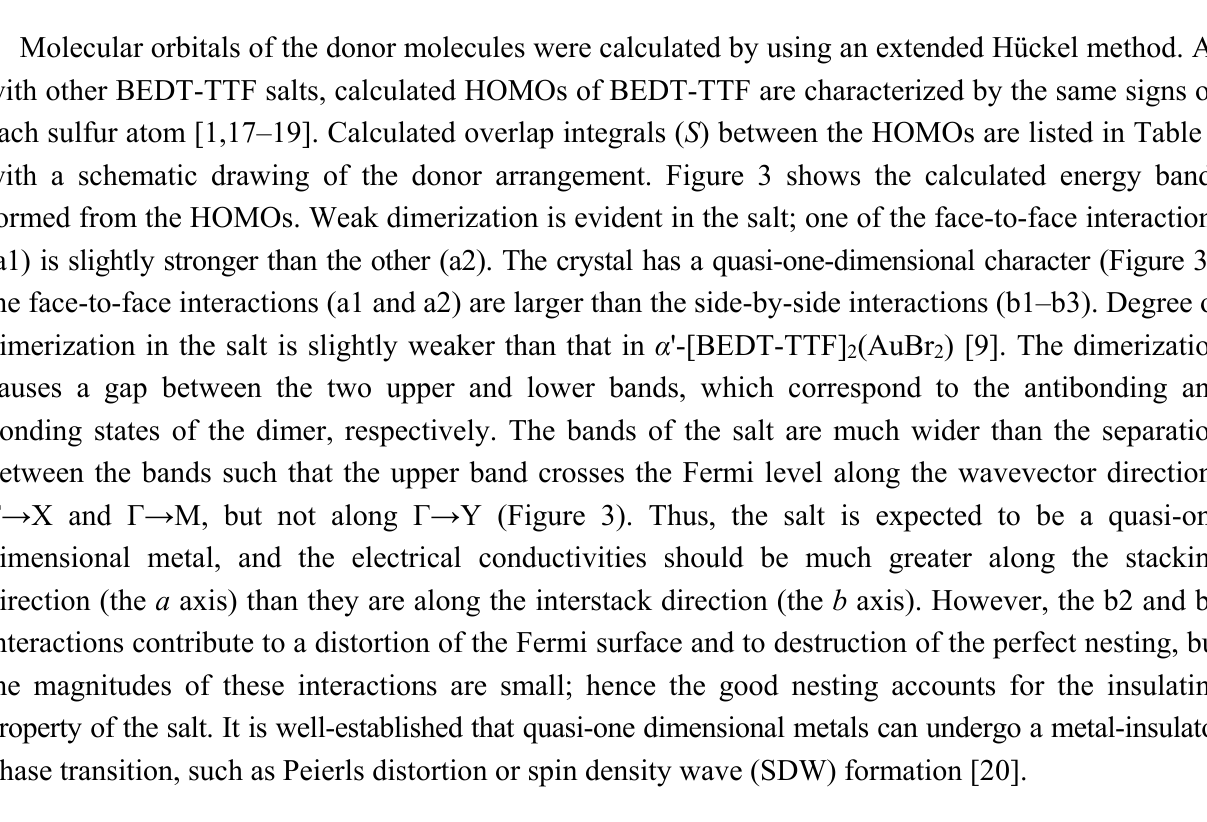
Table 3. Overlap integrals (×10 3 ) between the HOMOs of the BEDT-TTF with a schematic diagram of the donor arrangement in the